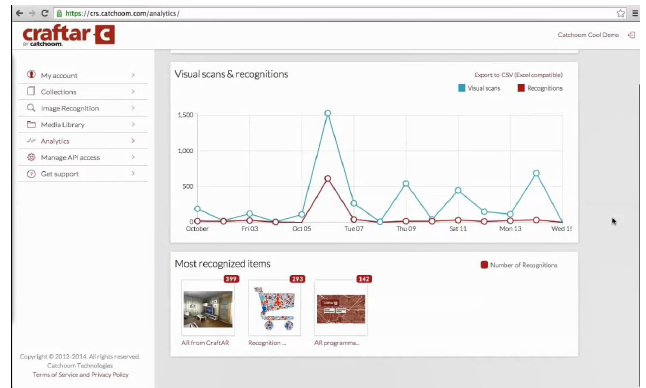
Figure 2. Analytics from a commercial AR solution. Only detection rates and most detected patterns are available.